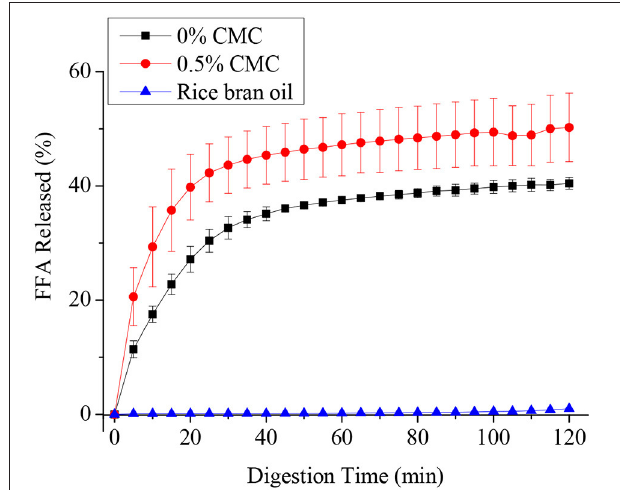
FIGURE 6 | Free fatty acids (FFAs) released from SPI-stabilized rice bran oil emulsions with 0.5 wt% CMC and pure rice bran oil after passing through an in-vitro digestion model (oral, gastric, and intestinal